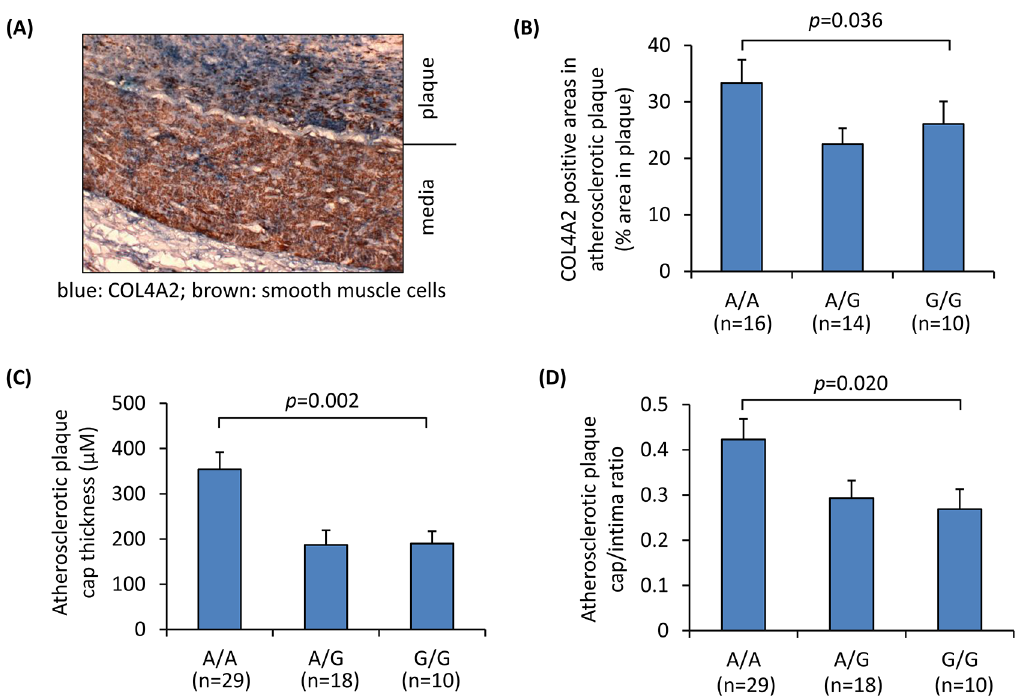
Fig 5. Association of SNP rs4773144 with collagen IV level in atherosclerotic plaques and plaque cap thickness. Atherosclerotic coronary arteries from different individuals were genotyped for SNP rs4773144 and subjected to histopathological analyses using Image-Pro software. (A) A representative image of immunostaining, blue color indicates COL4A2 staining, and brown smooth muscle alpha-actin. ×400 original magnification. (B) Percentages of COL4A2 immunostain positive areas in atherosclerotic plaques in different genotype groups. (C) Atherosclerotic plaque cap thickness in different genotype groups. (D) Atherosclerotic plaque cap/intima ratios in different genotype groups. Columns and error bars in B - D are mean and SEM values; p -values shown are for an additive genetic model.